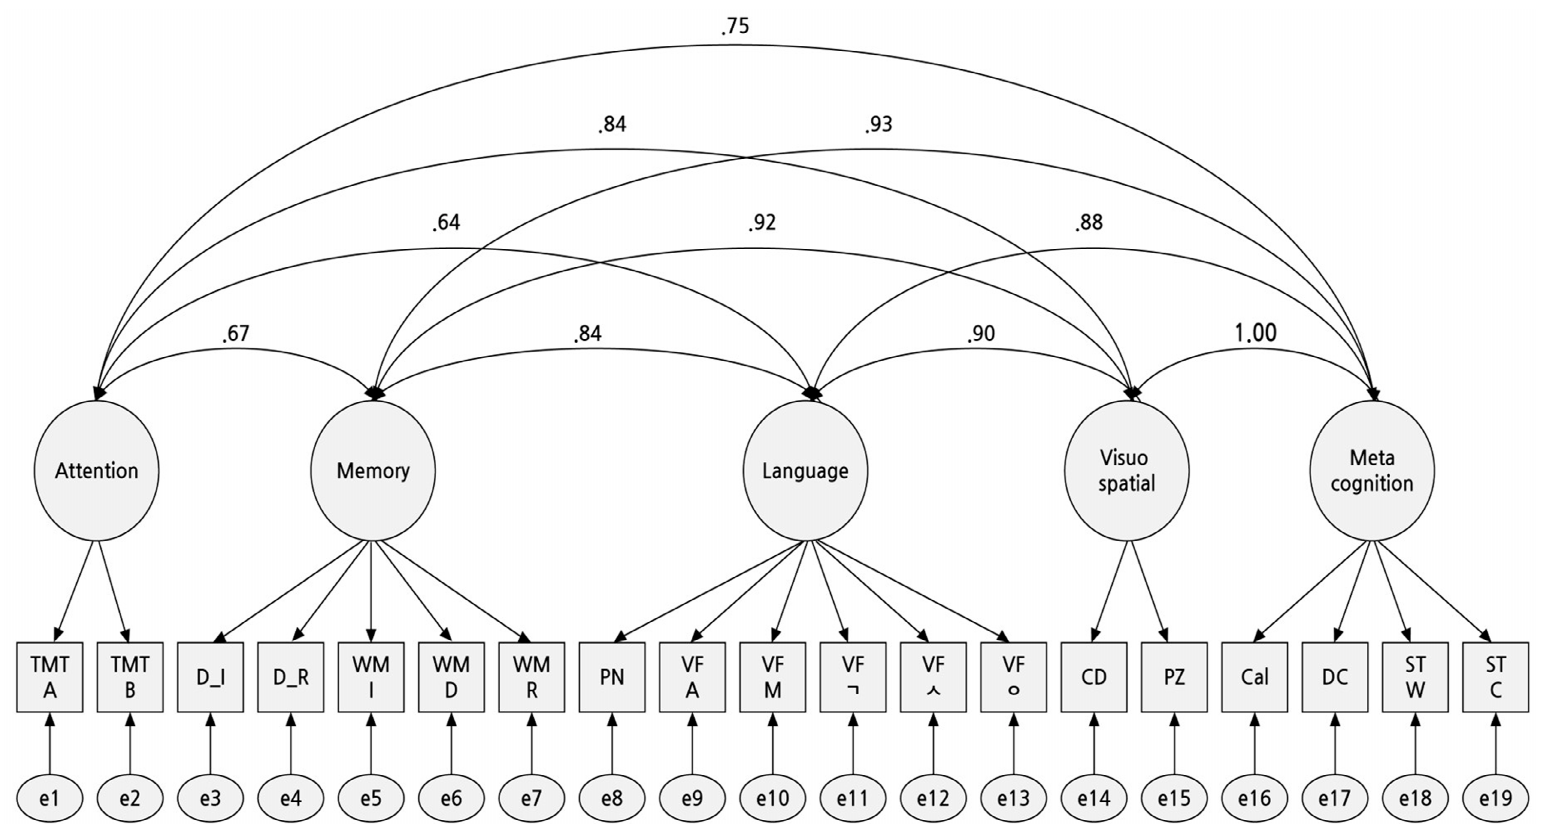
Figure 6. Confirmatory factor analysis model of Co-Wis.